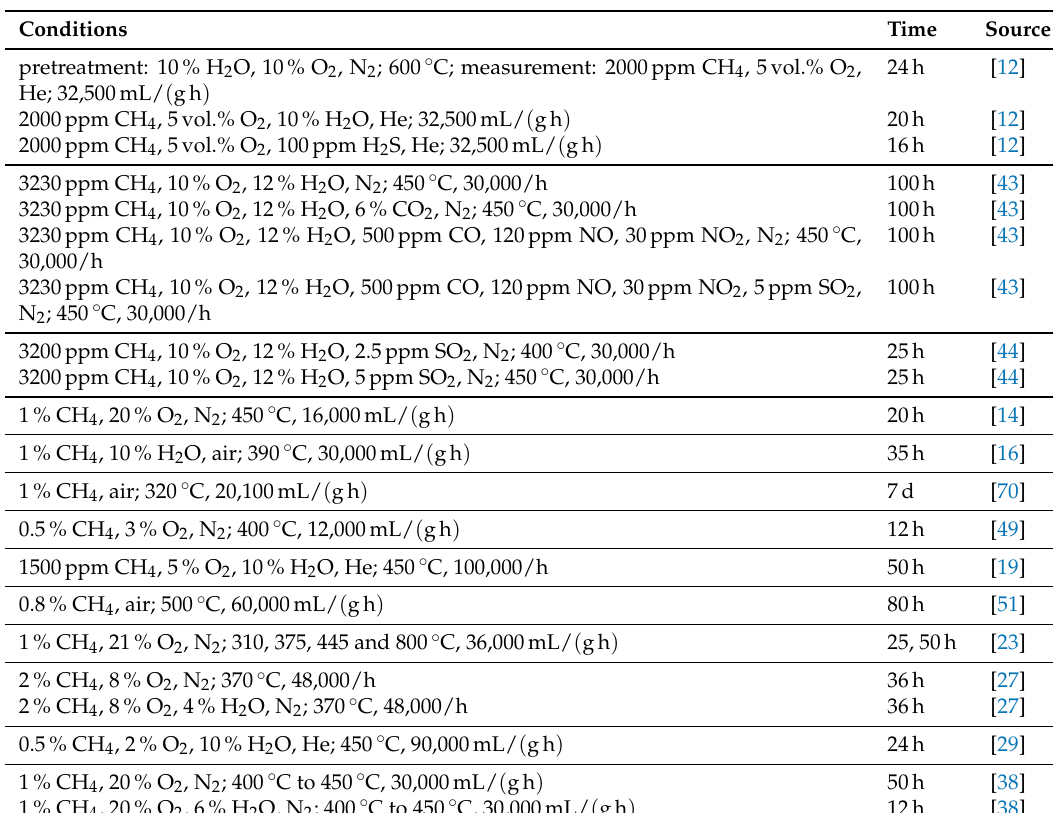
Table 5. Ageing conditions (gas composition, last gas used for balance; temperature, space velocity as WHSV or GHSV) and time for CH 4 abatement catalysts from literature. WHSV has been calculated from given data were applicable and